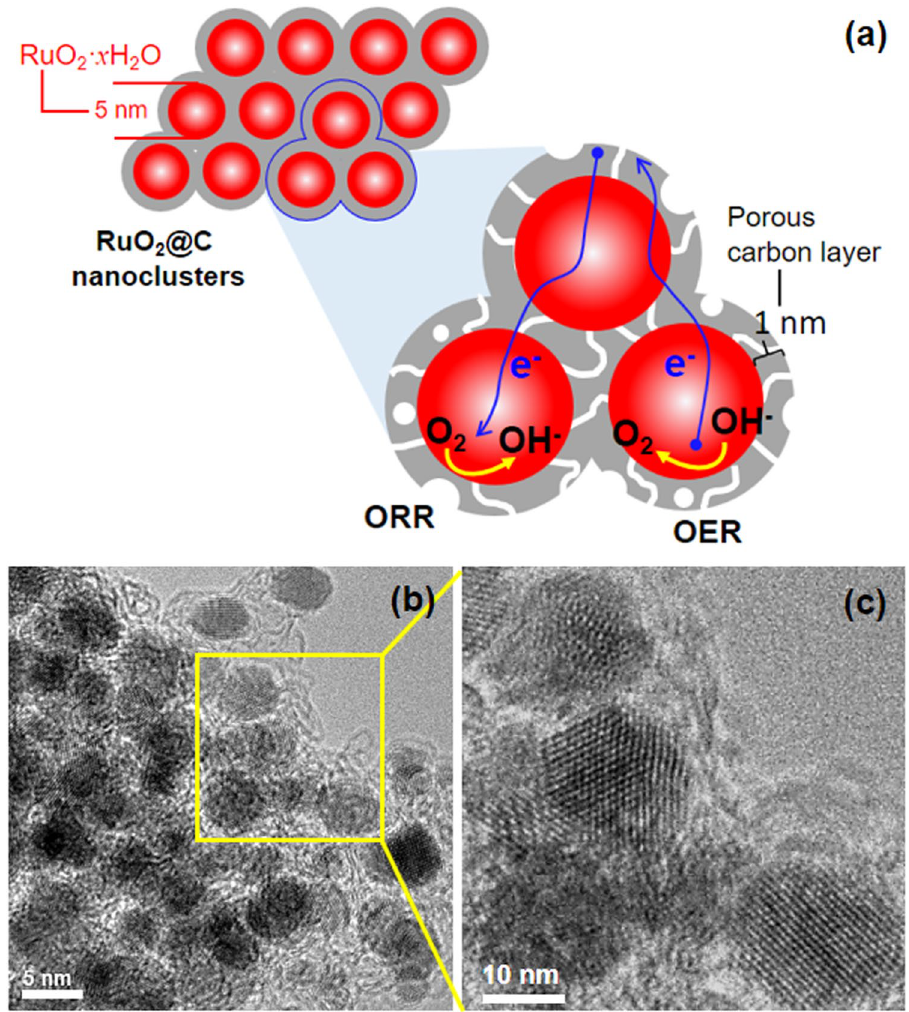
Figure 1. RuO 2 @C nanoclusters. ( a ) Schematic. ( b and c ) TEM